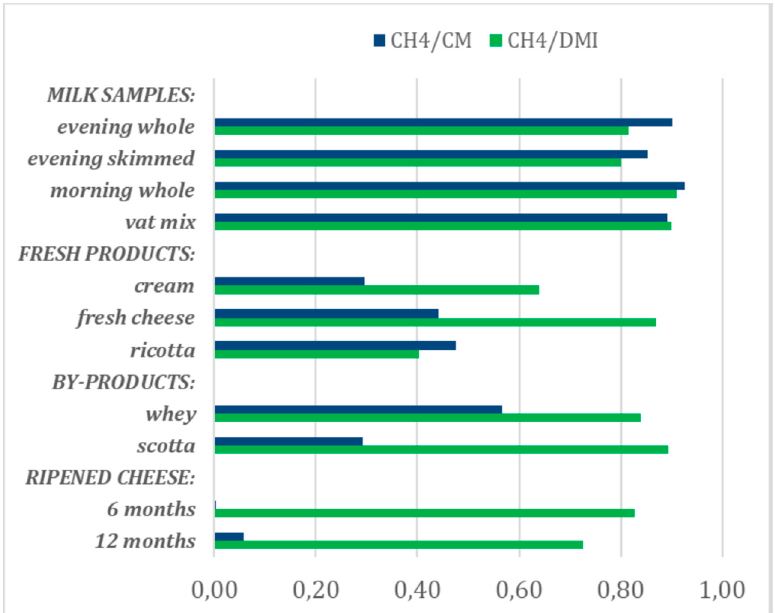
Figure 1. Pearson correlations between the bovine methane intensity per unit fat and protein corrected milk (CH 4 /CM) and methane yield per unit dry matter intake, (CH 4 /DMI) predicted on the reference bovine milk (average of evening and morning whole milk) and those predicted using other milk samples and dairy products and by-products.